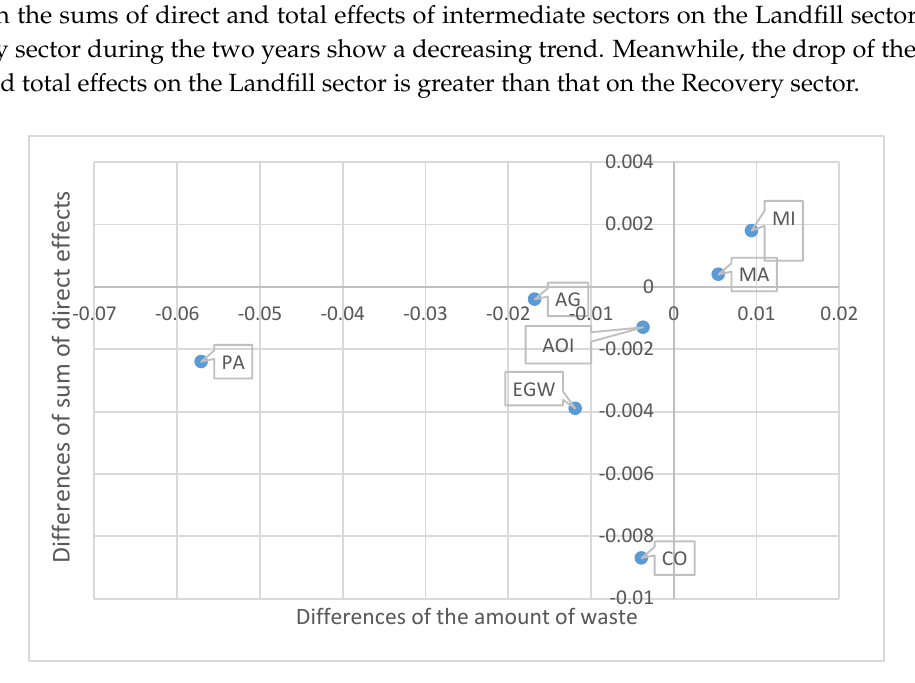
Figure 5. Relationships between differences of sum of direct effects and the amount of waste generation in various sectors of the Australian economy, YEAR. Agriculture, forestry, and fishing = AG; Mining = MI; Manufacturing = MA; Electricity, gas, and water = EGW; Waste management services = WMS; Construction = CO; Public administration = PA; All other industry = AOI.